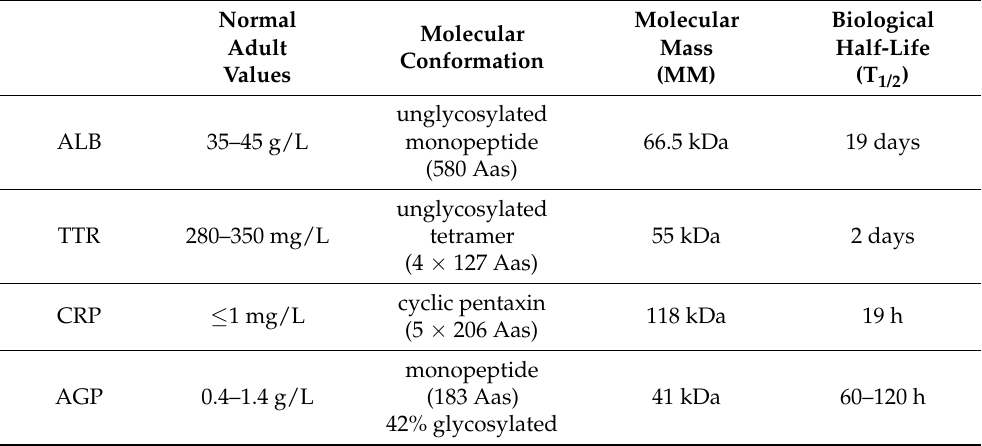
Table 1. Main physicochemical characteristics of biomarkers composing the pini formula.